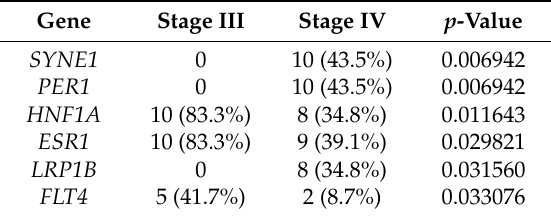
Table 3. Genes in which the presence of variants di ff ered significantly between stages III and IV patient samples (nominal p < 0.05; Fisher’s exact